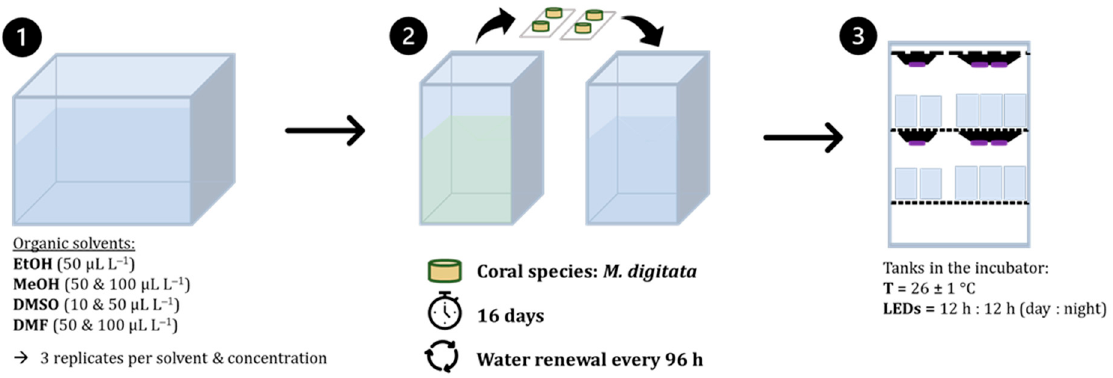
Figure 1. Schematic overview of the long-term experiment described here using Montipora digitata as the test organism. Coral discs (14–16 mm in diameter) were fixated on a glass slide and placed in a glass tank containing 1 L of water. The experiment was conducted over a period of 16 days, with the seawater replaced every 4 days (96 h).